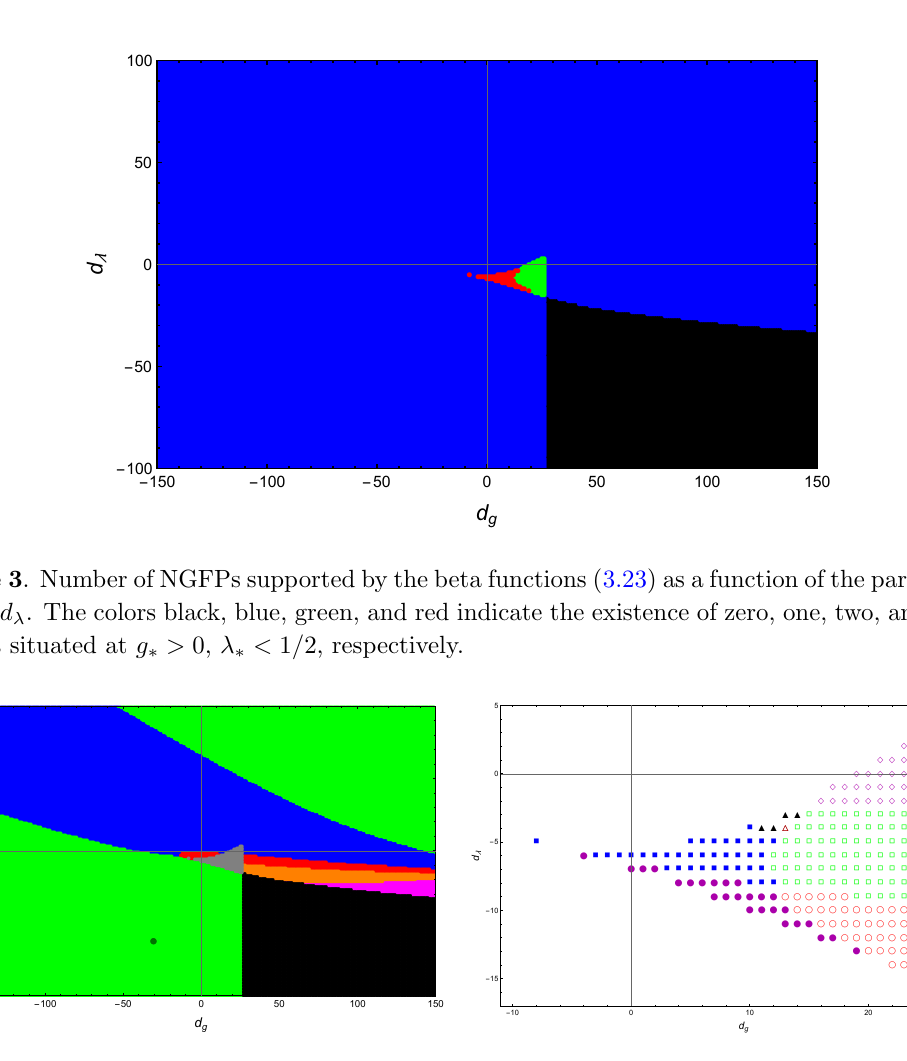
Figure 4 . Classi(cid:12)cation of the NGFPs arising from the beta functions (3.23) in the d g - d (cid:21) -plane, following the color-code provided in table 2. The left diagram classi(cid:12)es the stability behavior of the one-(cid:12)xed point sector. In particular, the black region does not support any NGFP while the regions giving rise to a single, UV-attractive NGFP with complex and real critical exponents are marked in blue and green, respectively. The (cid:12)eld content of the standard model is situated in the lower-left quadrant, ( d g ; d (cid:21) ) = ( (cid:0) 61 = 2 ; (cid:0) 62), and marked with a bold green dot. The gray area, supporting multiple NGFPs is magni(cid:12)ed in the right diagram with empty and (cid:12)lled symbols indicating the existence of two and three NGFPs,